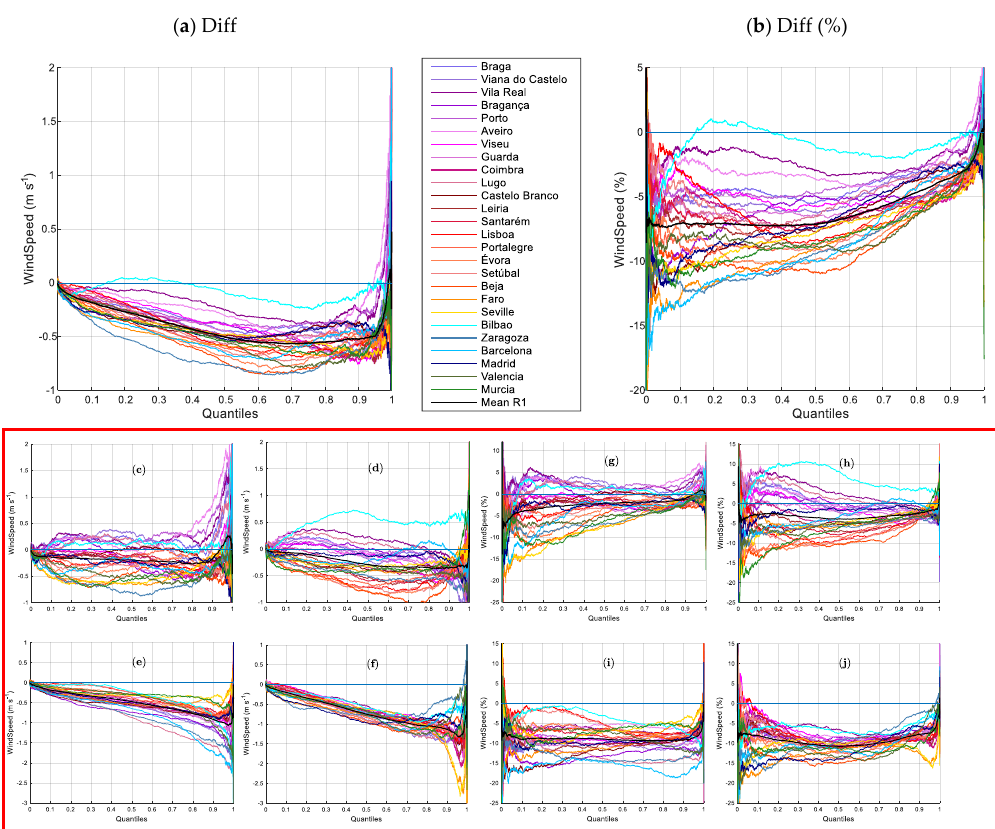
Figure 11. Differences (future-historic) for wind speed at 850 hPa for annual and seasonal conditions, as a function of the quantiles of the corresponding empirical distributions. ( a ) Absolute differences (m s −1 ) and ( b ) relative percentual differences (%). Seasonal absolute differences are also represented for ( c ) winter, ( d ) spring, ( e ) summer and ( f ) autumn, and Seasonal percentual differences for ( g ) winter, ( h ) spring, ( i ) summer and ( j ) autumn. The black line (Mean R1) refers to the mean of region 1 (total area).